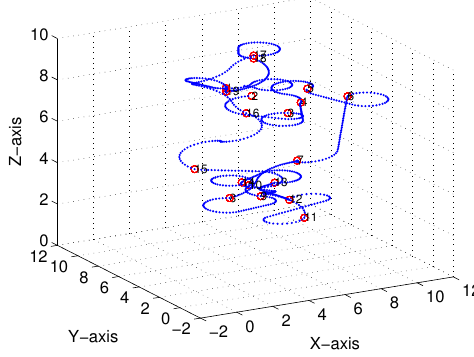
Figure 18. Linear-interpolation-based three-dimensional (3D) Dubins curves (case 2).